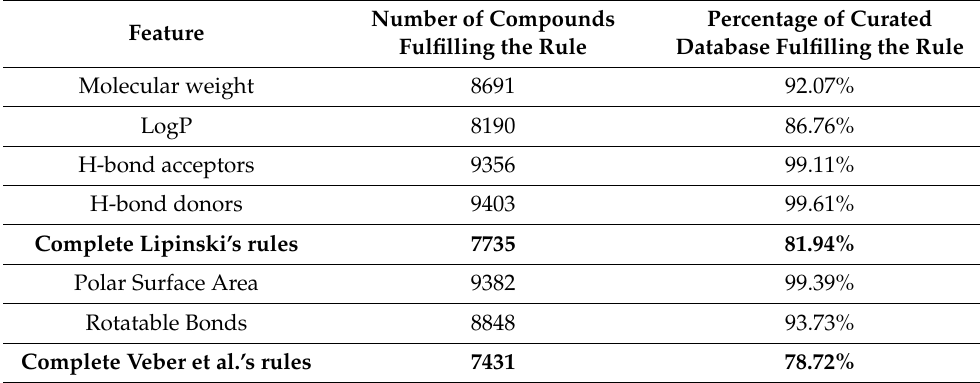
Table 1. Summary of compounds from the curated database fulfilling the rule of